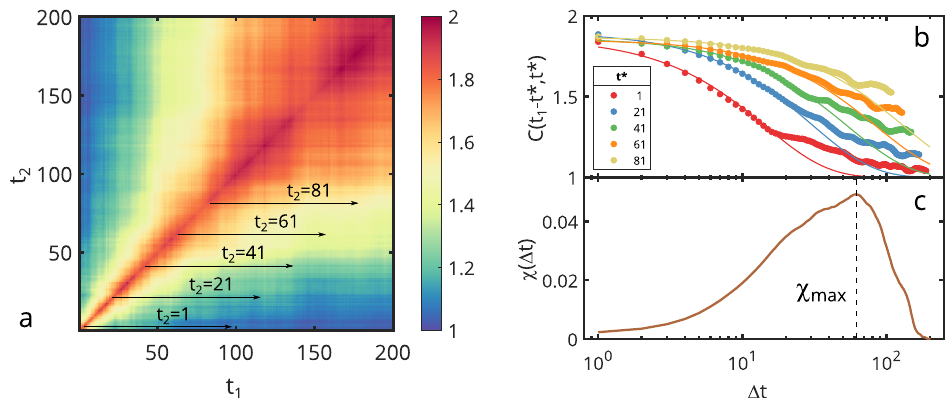
Figure 4. ( a ) Two-time correlation matrix C ( t 1 , t 2 ) modelled for an aging system that continuously slows down during the measurement. ( b ) Cuts through C at given t 2 = t ∗ as indicated in ( a ). The lines are exponential fits up to ∆ t = t 1 − t ∗ = 20, afterwards the modelling fails because of the aging. ( c ) Variance χ from ( a ). The maximum χ max is found at about ∆ t = 61 and marked by the dashed